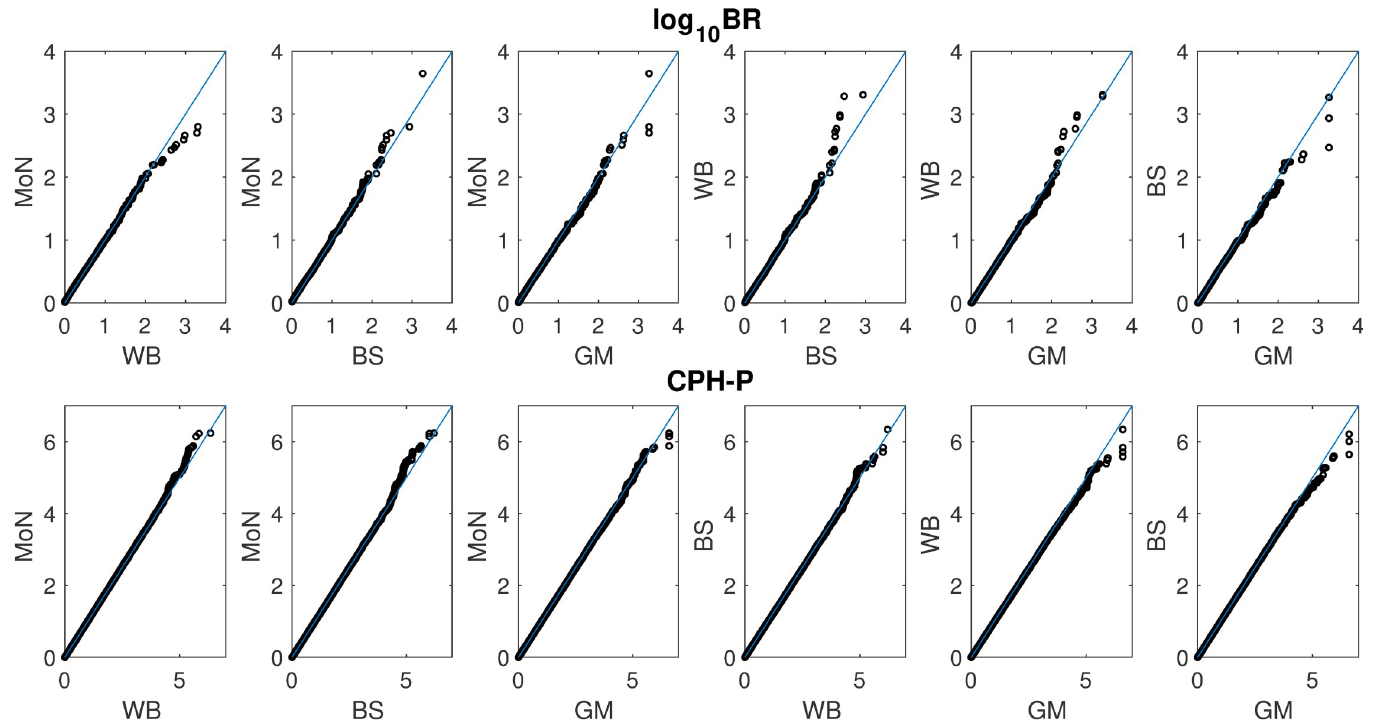
Fig 2. Comparative QQ plots for log 10 BR and CPH-P, respectively, as a function of generating form of S. Shown here are QQ plots for all possible pairs of generating distributions for S (Mixture of Normals (MoN), Weibull (WB), Birnbaum-Saunders (BS), Gamma (GM), for N = 400, based on 1,000,000 replicates per generating condition.